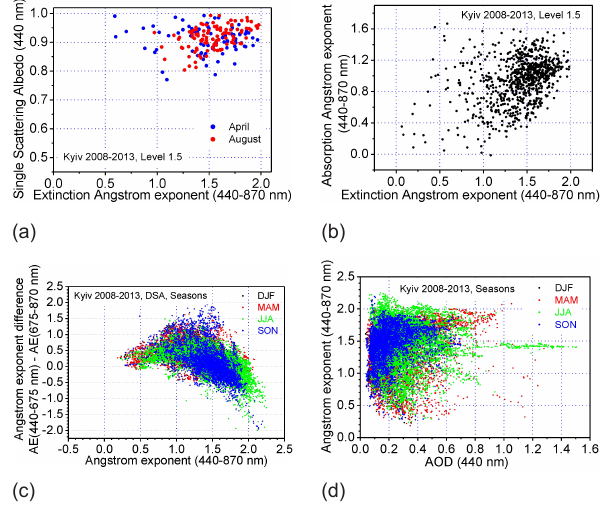
Figure 8. (a) Scatter plot SSA versus extinction Ångström expo- nent (EAE) for April and August months separately, (b) absorp- tion Ångström exponent versus EAE (440–870nm). (c) Seasonal scatter plot Ångström exponent difference (AE (440–675nm)– AE (675–870nm)) versus Ångström exponent (440–870nm), and (d) Ångström exponent (440–870nm) versus AOD (440nm). Data from the Kyiv AERONET